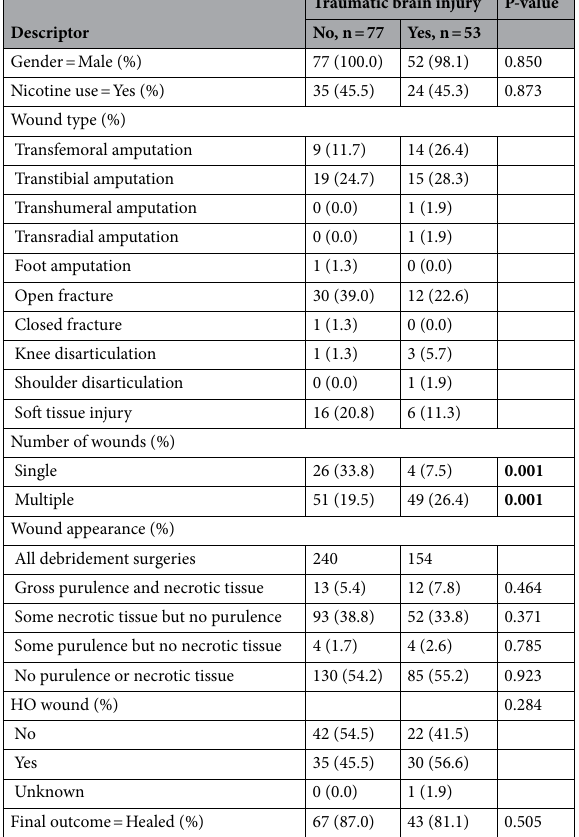
Table 1. Clinical characteristics of trauma patients with extremity wounds (TBI vs. non-TBI, analyzed by Chi- square). Significant values are in